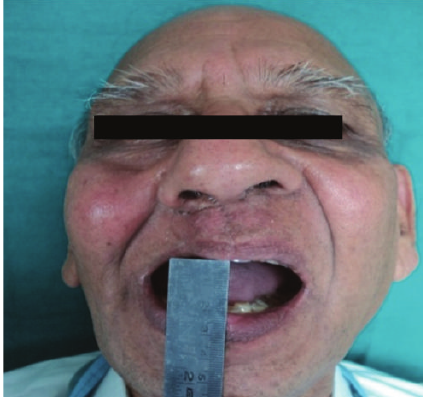
Figure 4: Primary